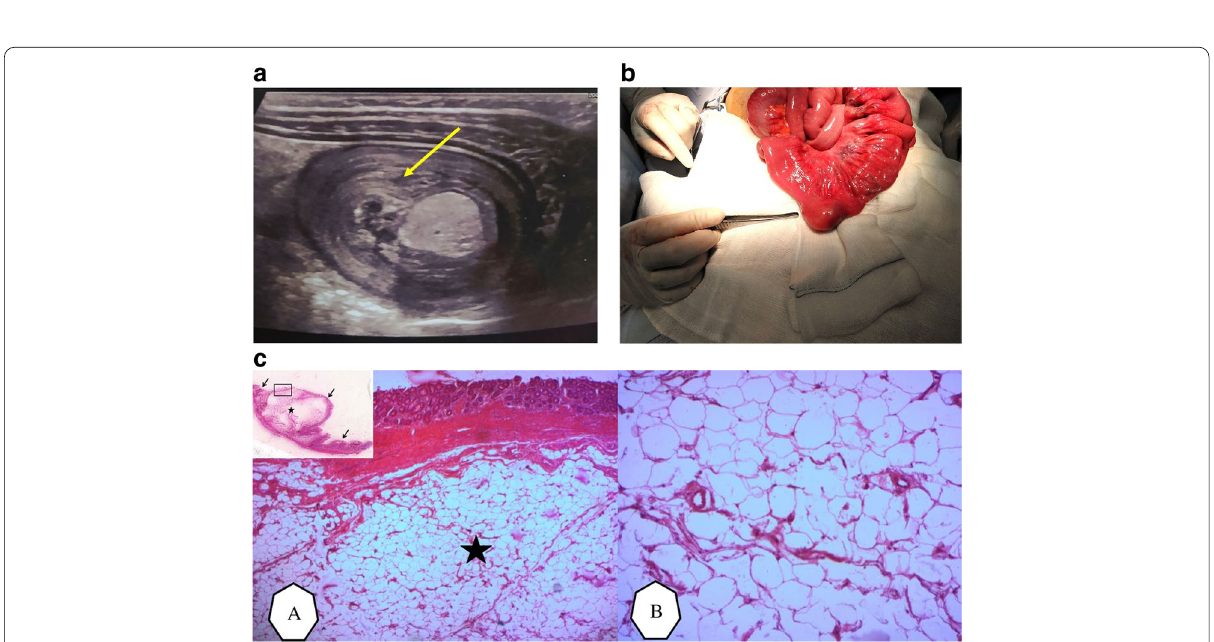
Fig. 1 a Sub-hepatic target sign at abdominal ultrasound revealed an intussusception (yellow arrow). b Intraoperative view of a submucosal ileal lipoma. c Histology image of ileal lipoma. A: Low power examination showed lobules of fat separated by delicate fibrovascular trabeculae (*). (HE 25). B: A high power examination showed mature fat cells with no malignant features. (HE